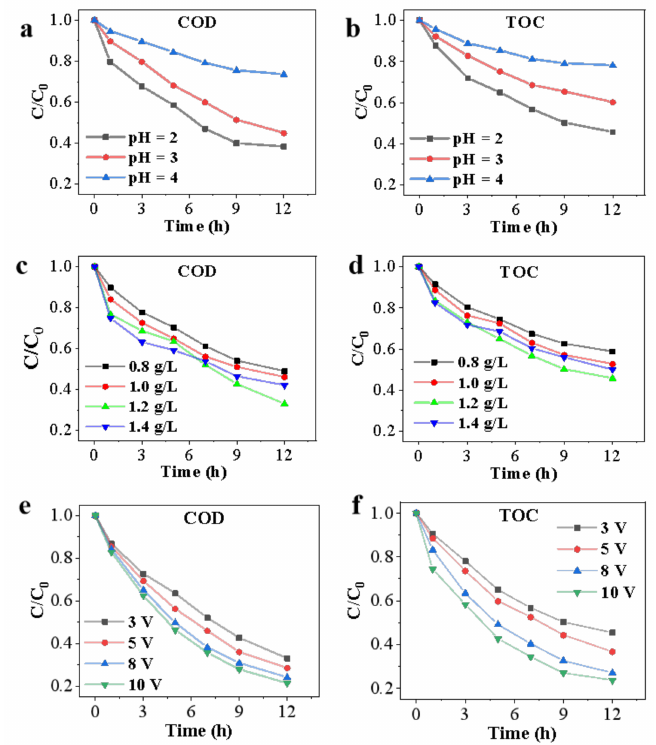
Figure 2. Effect of initial pH ( a , b ), ( c , d ) the dosage of ZVI, and the applied voltage ( e , f ) on COD and TOC removal percentage for the 500 mL